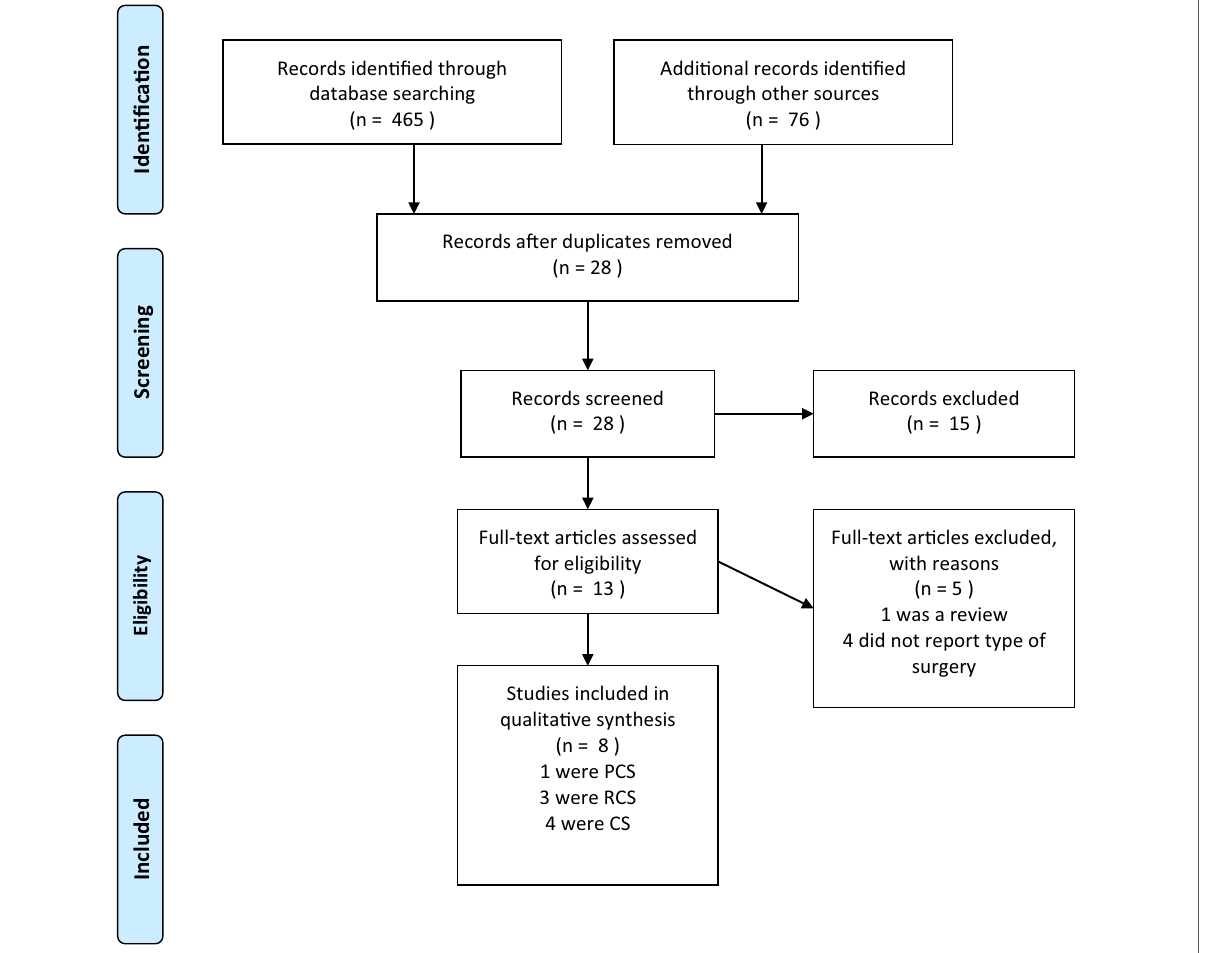
Fig. 1 PRISMA 2009 flow diagram (from Ref.